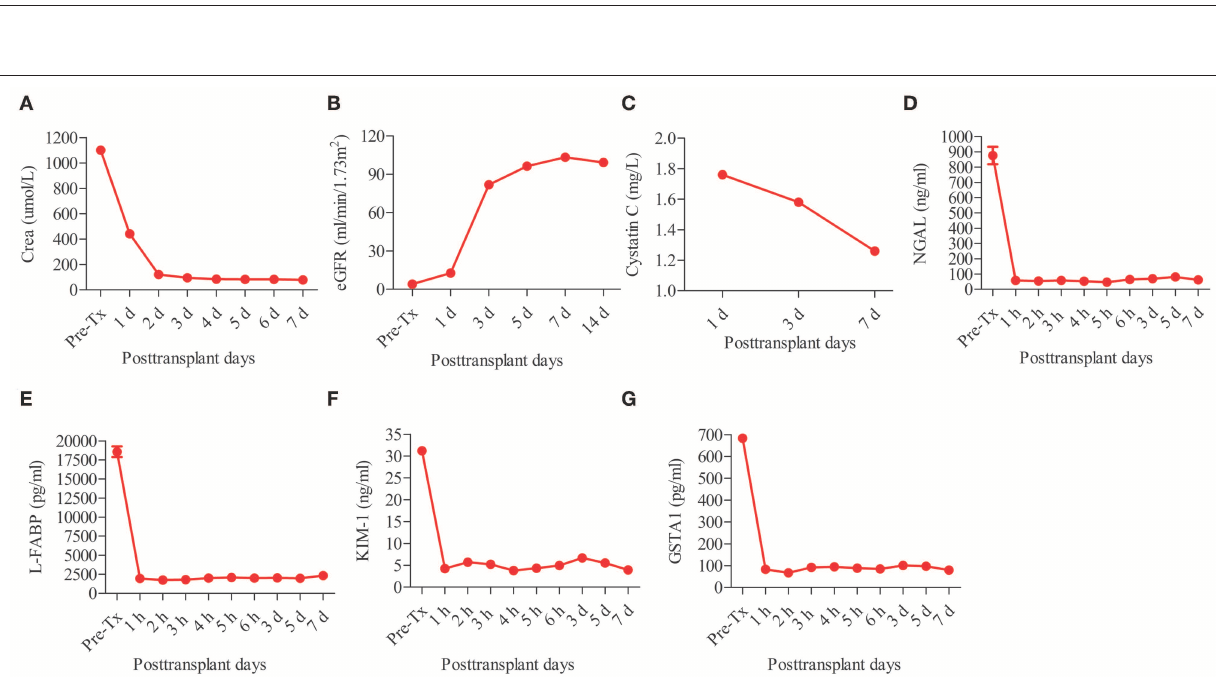
Frontiers in Medicine |